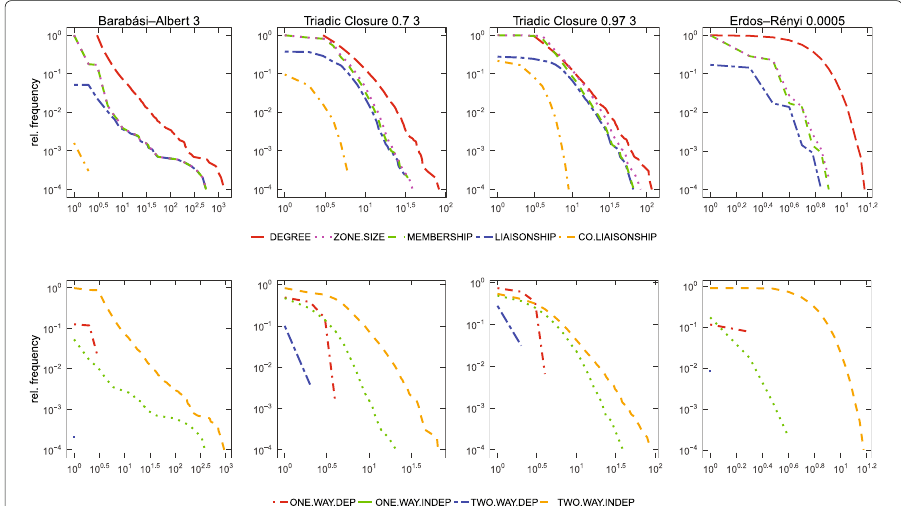
Fig. 9 Node and zone properties in generated networks. The upper row shows distributions of degree and four zone-related properties of four selected generated networks. It can be seen that the shapes of these four distributions copy the shape of the degree distribution. Moreover, it is clear that three of them (zone size, liaisonship, membership) have almost identical distributions, while for liaisonship it is true approximately from the value of 10. The lower row shows the distributions of properties related to types of node dependencies. A common characteristic of all the networks is a very low (or zero) number of neighbors on which the nodes are dependent (OwDep and TwDep properties). Moreover, the shape of the distribution of the TwIndep property copies the shape of the node degree distribution, with nodes not being dependent on most of their neighbors (higher TwIndep values